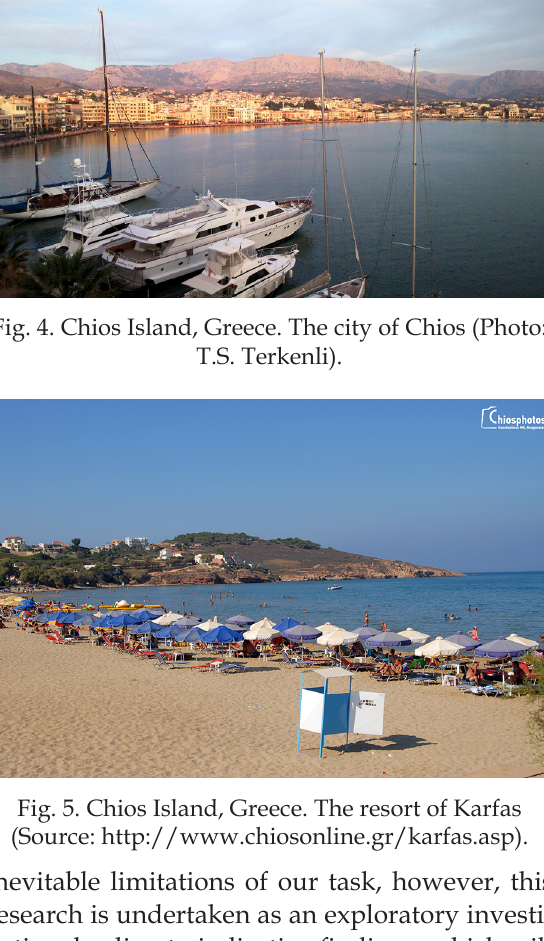
Fig. 3. Zwierzyniec, Poland. The baroque church of St. john of Nepomuk (Photo: E. Skowronek).